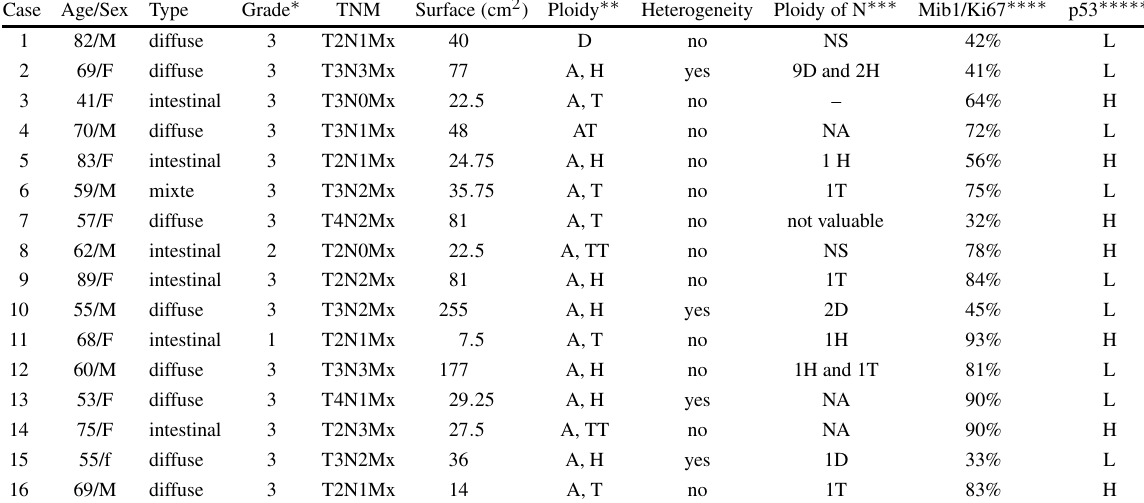
Pathological data and DNA ploidy in advanced gastric cancers